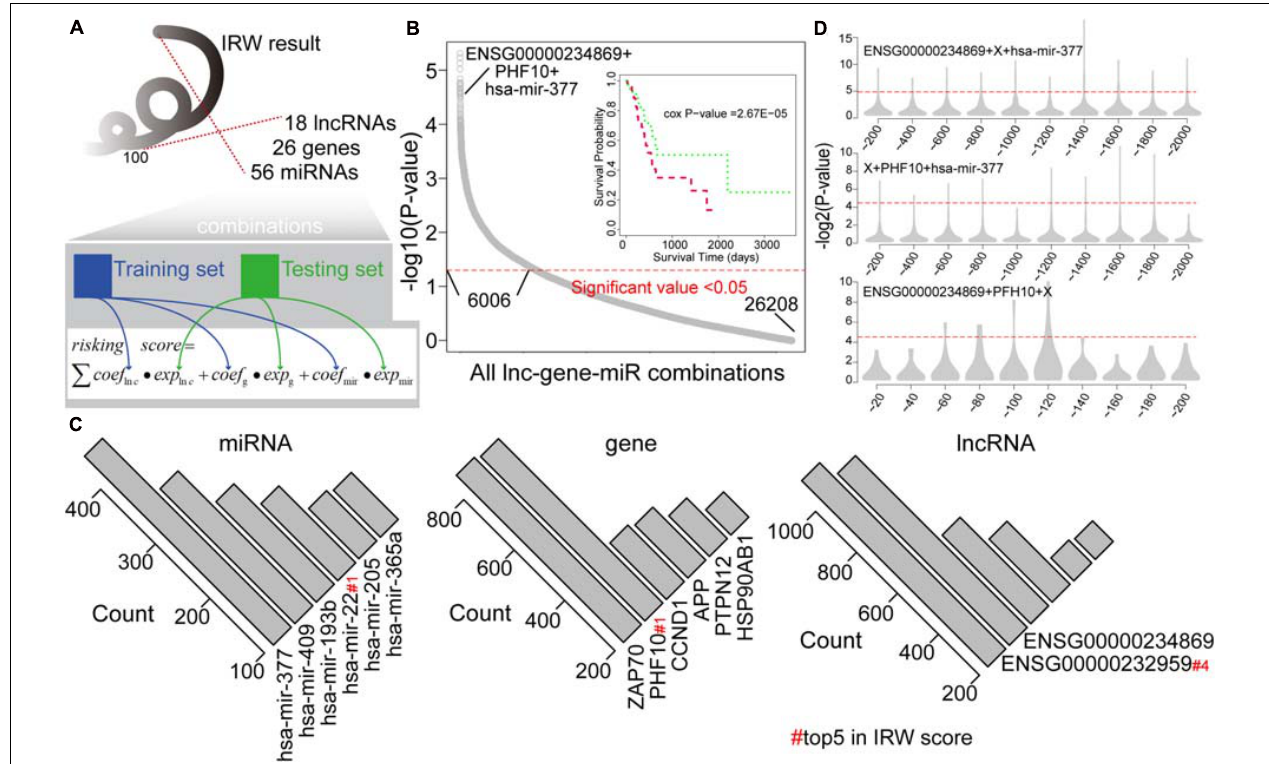
FIGURE 3 | (A) The framework for constructing all lncRNA-gene-miRNA combinations and calculating the risk score based on each combination. (B) Distribution of prognostic related combinations within all combinations. A K-M plot, for example, ENSG00000234869 + PHF10 + hsa-mir-377. (C) The robust signatures for miRNA, gene, and lncRNA within all prognostic related combinations. (D) Random results when changing each molecule from the example combination in label (B) by molecules with low IRW